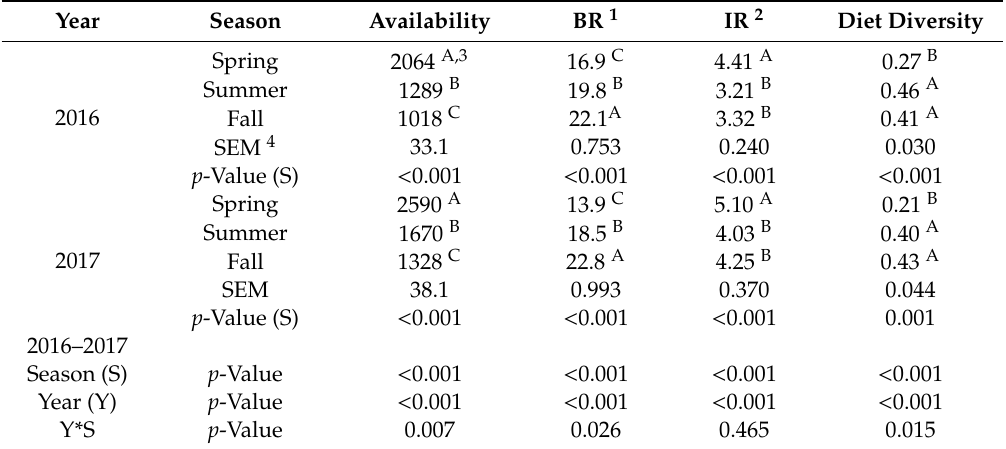
Table 1. Forage availability (kg DM / ha), bite rate (bites / min), intake rate (g DM / min), and diet diversity (index) of goats browsing a Southern Mediterranean forest rangeland during 2016 and